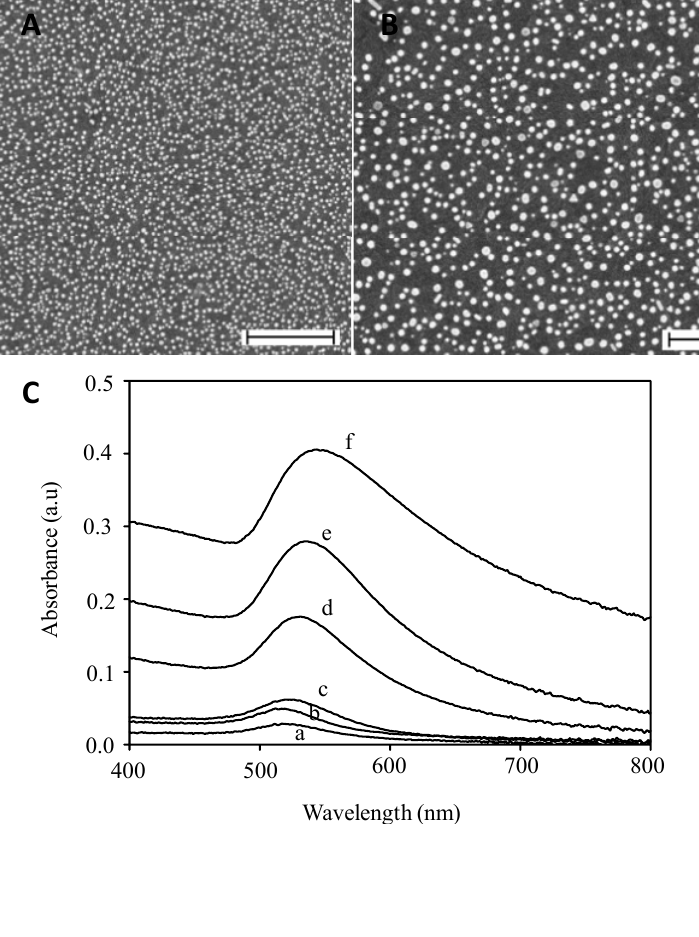
Figure 2. ( A and B ) FESEM images of spherical gold nanoparticles that were grown on the surface for 2 h in the growth solution; ( C ) The optical absorption spectrum of gold nanoparticles on the surface that was grown for different growth time, namely (a) 0.5; (b) 1; (c) 2; (d) 4; (e) 8 and (f) 16 h. Scale bars in A and B are 100